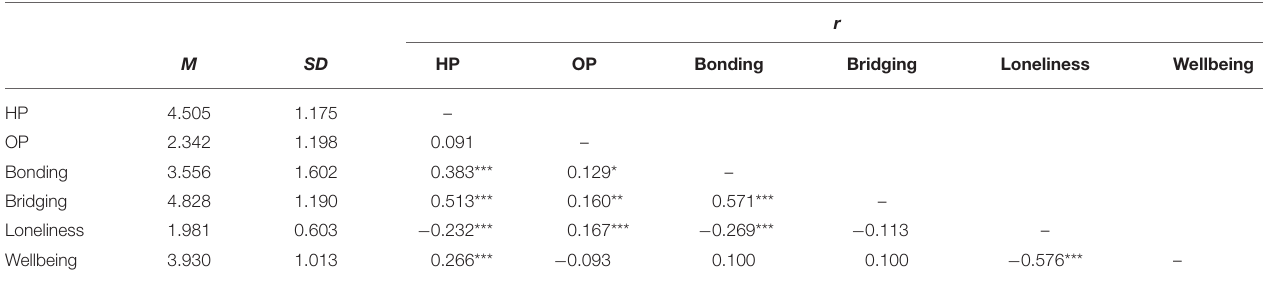
TABLE 1 | Means, standard deviations, and correlations for harmonious (HP) and obsessive passion (OP), in-game bonding (Bonding) and bridging (Bridging) social capital, loneliness, and